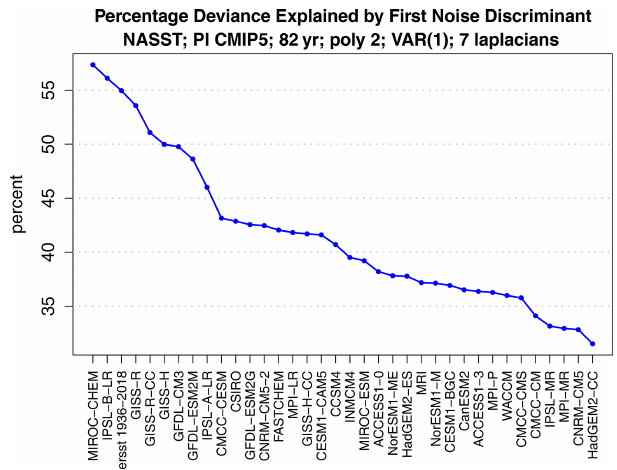
Figure 3. Percent of deviance D 1 : 2 explained by the first noise dis- criminant, for the variance ratios shown in Fig.